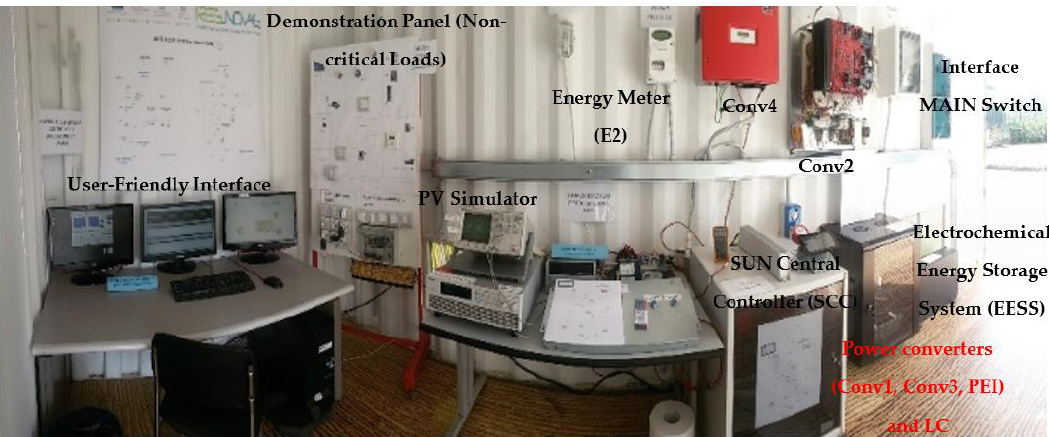
Figure 5. The SUN installed at the pilot site.